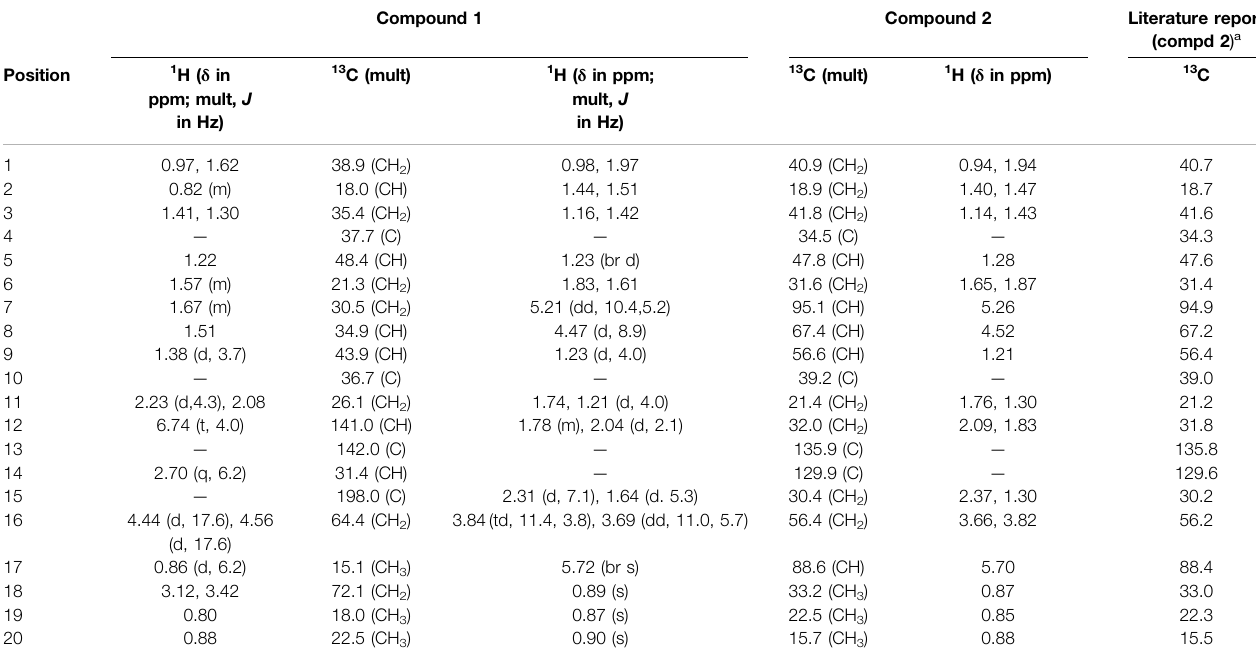
TABLE 1 | 1 H NMR data for compounds 1 (at 500 MHz) and 2 (at 400 MHz) in CDCl 3 . Compound 1 Compound 2 Literature report